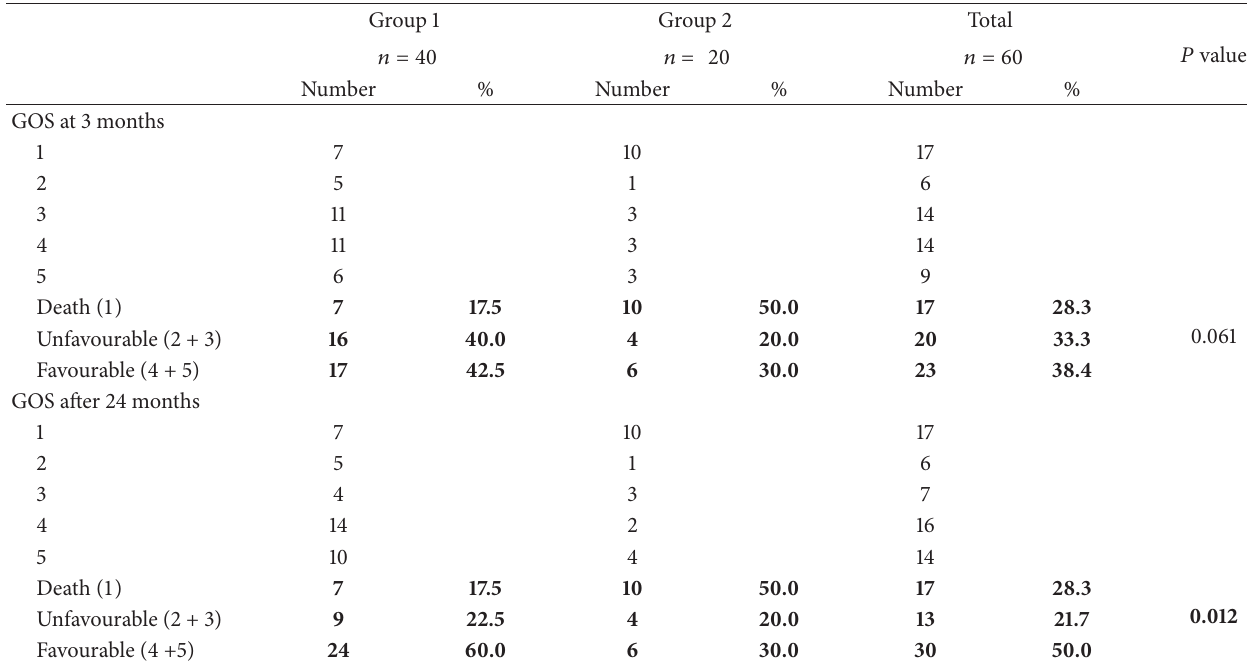
Table 2: Functional outcome of the patients evaluated by the Glasgow Outcome Scale (GOS) 3 months and more than 24 months after decompressive